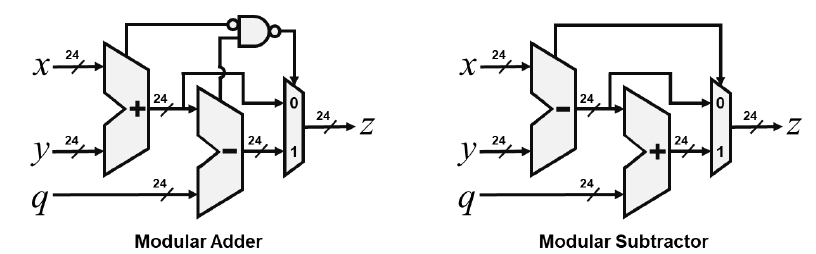
Figure 1: Design of our modular adder and subtractor with configurable modulus q .